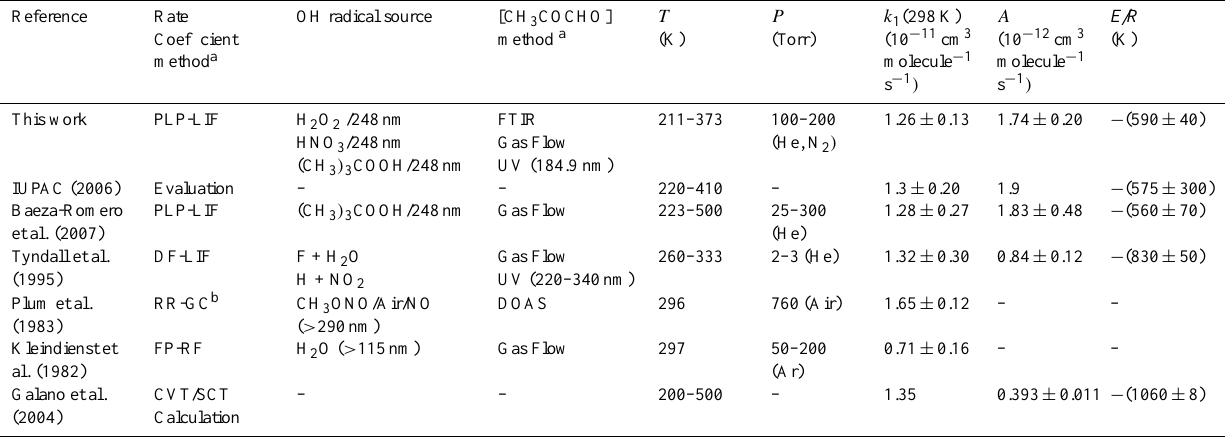
Table 3. Summary of rate coefficient data, k 1 ( T ), for the reaction OH + CH 3 COCHO → products.